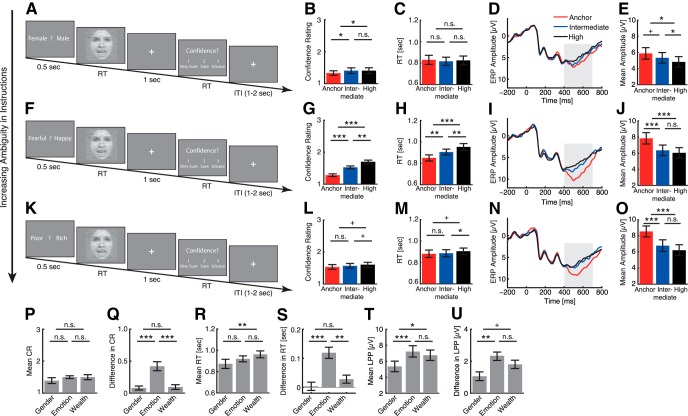
Experiments 4–6. A–E, Experiment 4: gender judgment task. F–J, Experiment 5: emotion judgment task. K–O, Experiment 6: wealth judgment task. A, F, K, Task. A question prompt was presented for 500 ms, followed by the stimulus. Subjects were instructed to respond as quickly as possible, and the stimulus stayed on the screen until subjects responded. B, G, L, Confidence ratings (CR). Confidence ratings systematically varied as a function of stimulus ambiguity for the emotion judgment task but not for the gender judgment task nor wealth judgment task. C, H, M, RT. RT can be considered as an implicit measure of confidence, and had a similar pattern as confidence ratings. D, I, N, ERP at the electrode Pz. Gray shaded area denotes the LPP interval. E, J, O, Mean LPP amplitude. Error bars denote one SEM across subjects. Paired t test between adjacent levels of ambiguity: +, p < 0.1; *, p < 0.05; **, p < 0.01; ***, p < 0.001; n.s.: not significant. P, Mean confidence rating for each experiment. Q, Difference in confidence rating between anchor and high-ambiguity stimuli for each experiment. R, Mean RT for each experiment. S, Difference in RT between anchor and high-ambiguity stimuli for each experiment. T, Mean LPP averaged across all conditions for each experiment. U, Difference in LPP between anchor and high-ambiguity stimuli for each experiment. Error bars denote one SEM across subjects. Paired t test between subjects: +, p < 0.1; *, p < 0.05; **, p < 0.01; ***, p < 0.001; n.s., not significant.